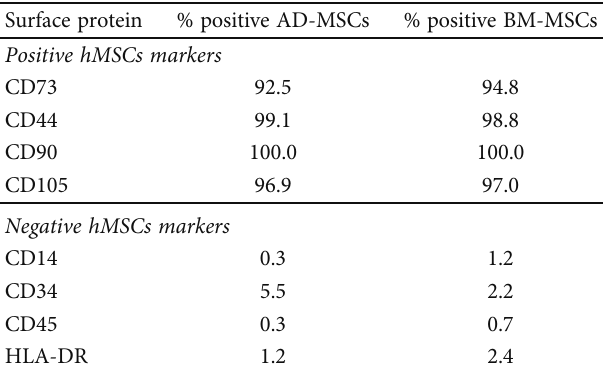
Figure 3: Immunophenotypic characterization of the surface of (a) AD-MSCs and (b) BM-MSCs using fl ow cytometry. The representative images showed the both type of MSCs expressed at least 85% of double-positive expression, double-negative, or coexpressed its positive and negative markers. Table 2: Flow-cytometric analysis of expanded passaged-2 AD- MSCs and